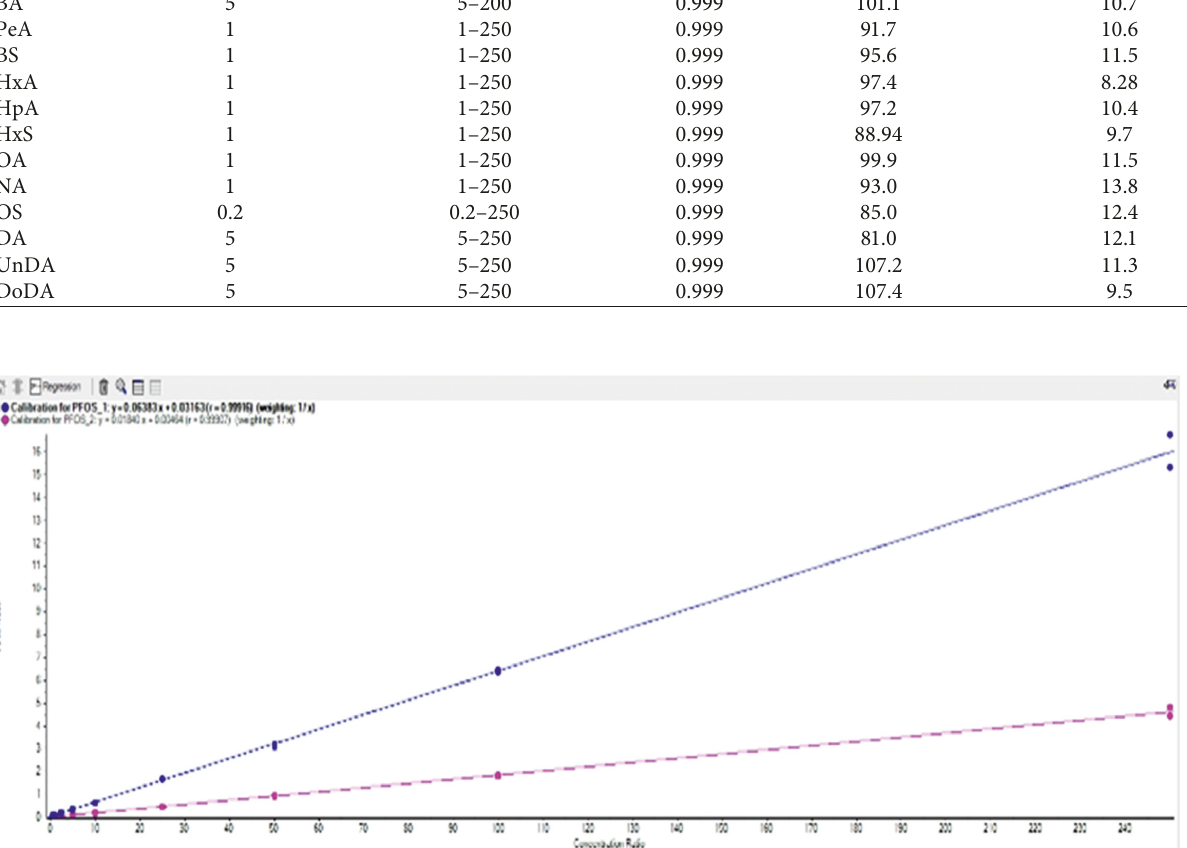
Figure 2: PFOS calibration curve in the range from 0.2 to 250ng · L − 1 . Dotted blue line represents m/z transition 499 → 80; dotted red line represents m/z transition 499 → 99.